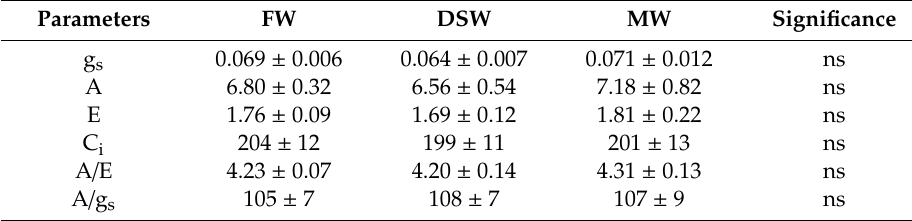
Table 2. Mean stomatal conductance (g s , mol H 2 O m − 2 s − 1 ), net photosynthesis (A, µ mol CO 2 m −